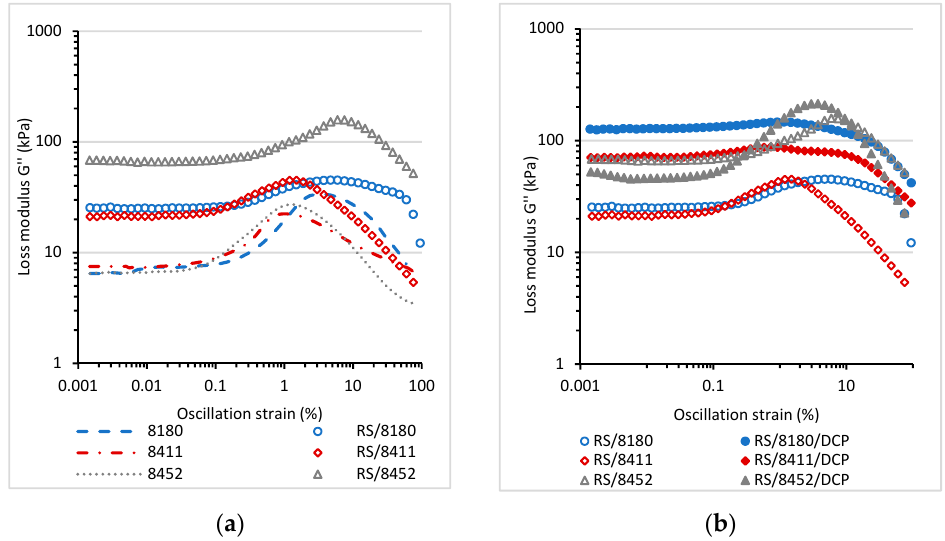
Figure 5. The loss shear modulus G ’’ as a function of oscillation strain (%) for neat TPE and RS/TPE blends ( a ) and cured RS/TPE/DCP blends ( b ). Conditions of measurements: angular frequency 10 rad ⋅ s − 1 , temperature 25 °C.